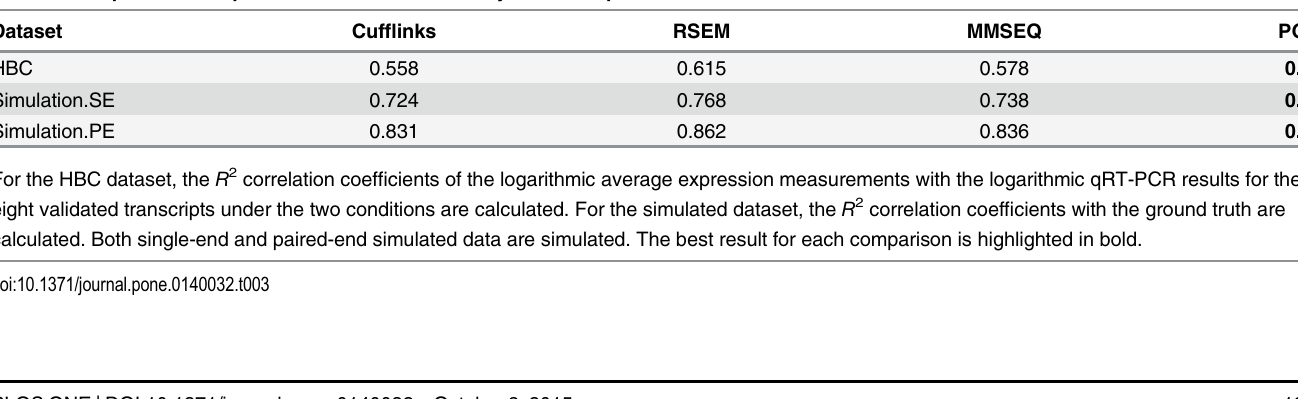
Table 3. Comparison of expression estimation accuracy at transcript